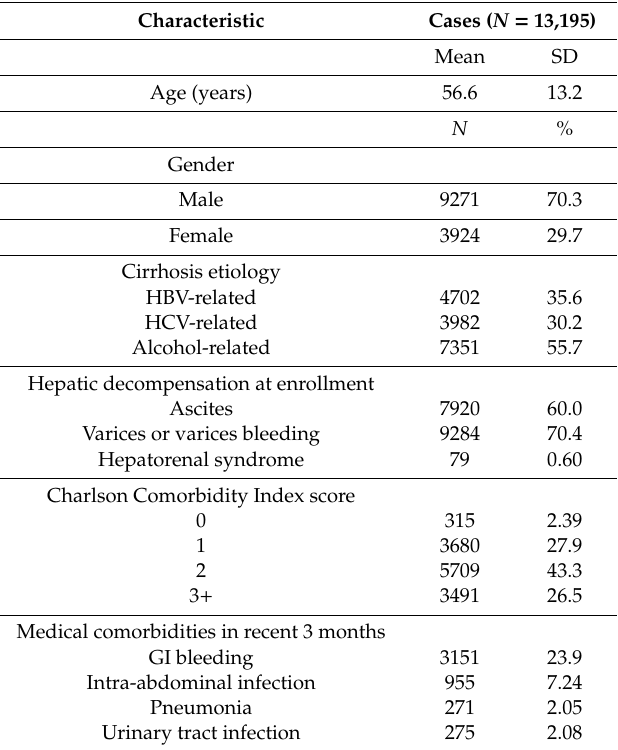
Table 1. Demographic data of patients with decompensated cirrhosis and hepatic encephalopathy. HBV: hepatitis B virus; HCV: hepatitis C